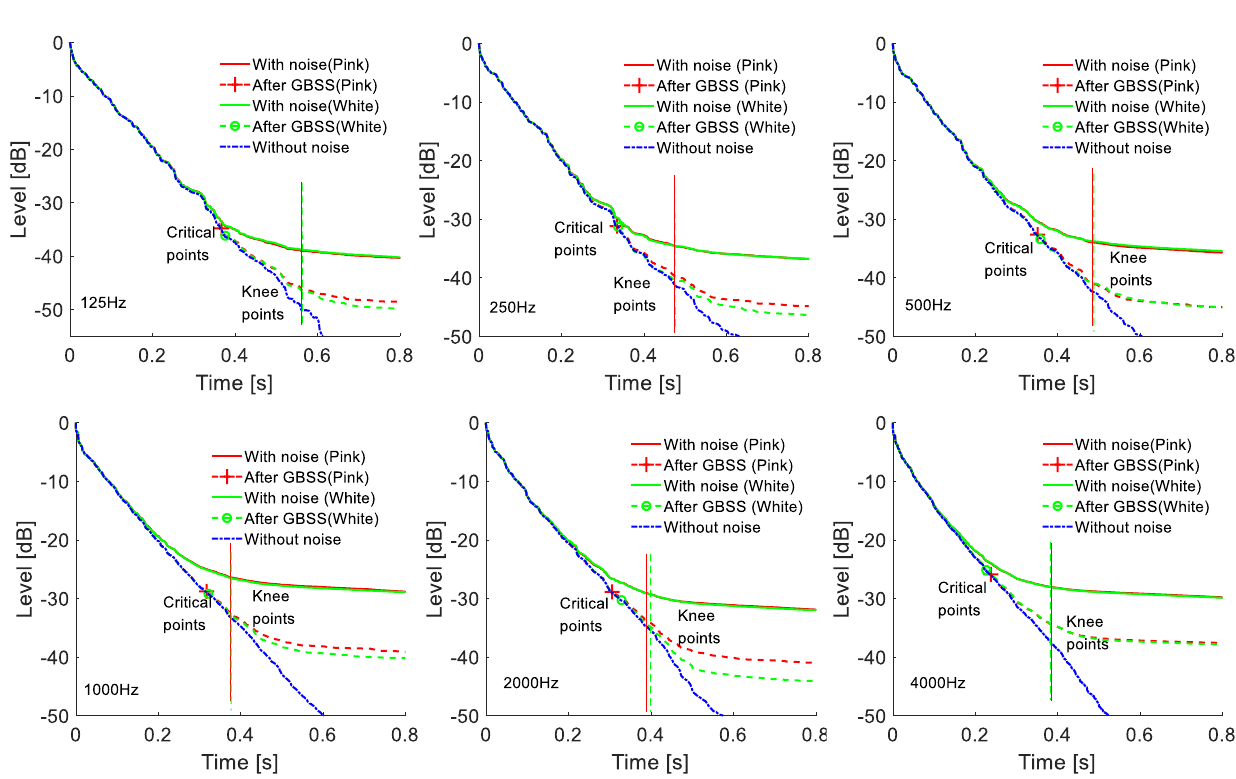
Figure 5. De-noising effects using the optimal set factors of the GBSS on the RIRs of the meeting room with different added noises filtered at the octave bands. The red dotted line is the EDCs with the pink noise. The green dotted line is the EDCs with white noise.